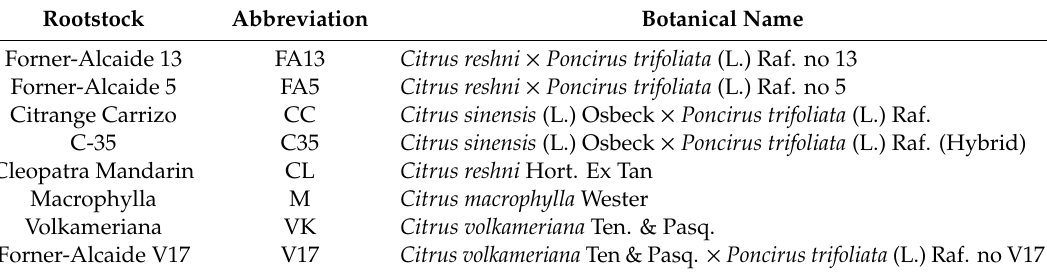
Table 1. Description of the rootstocks tested for ‘Clemenules’